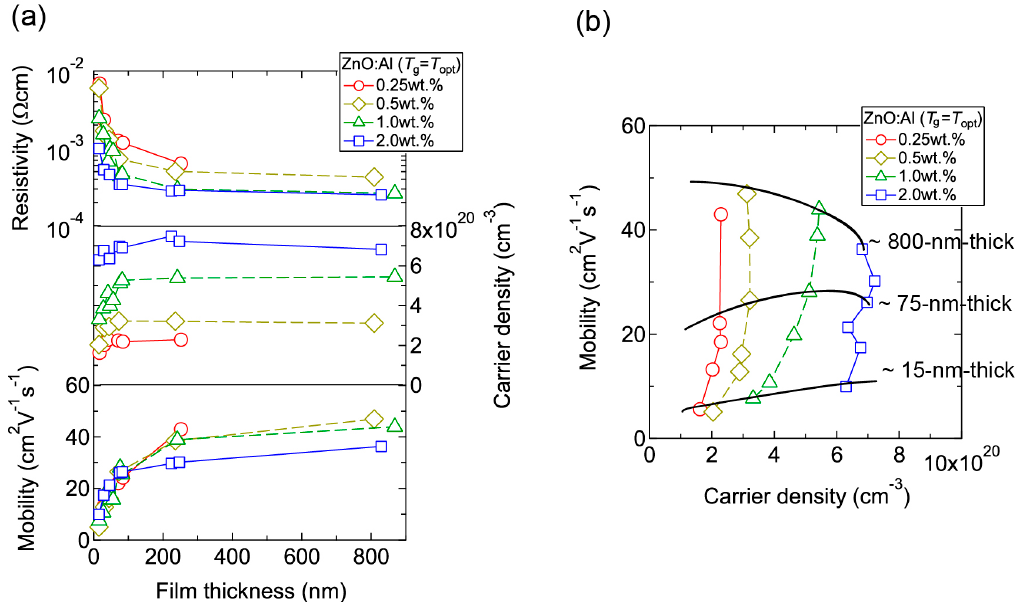
Figure 6. ( a ) Plots of resistivity, carrier density, and mobility in ZnO:Al (0.25, 0.5, 1.0, and 2.0 wt %) films as a function of film thickness; ( b ) Relationship between carrier density and mobility for the films.